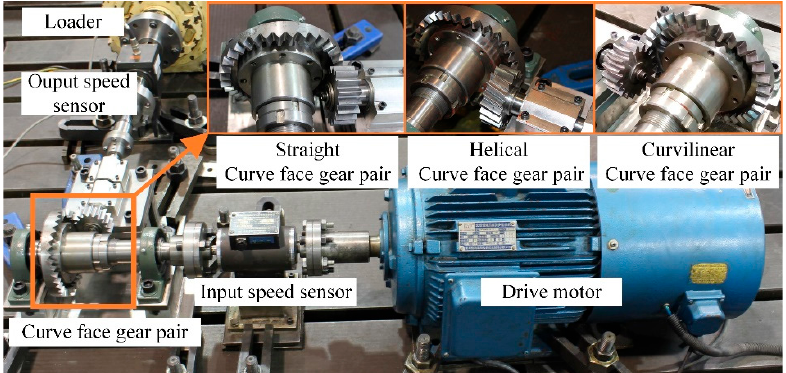
Figure 17. Transmission experiment of the curve face gear pairs with different tooth profiles.